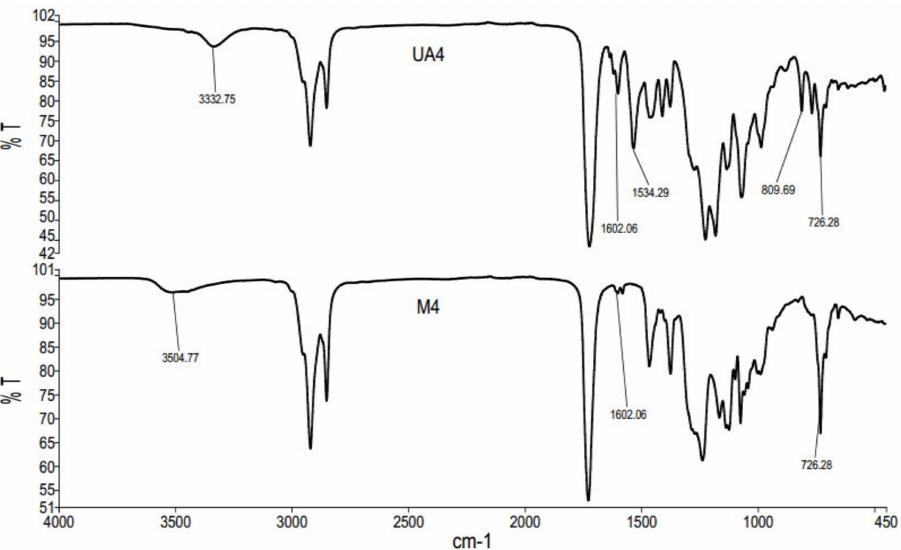
Figure 5. Comparison of the FTIR spectra between the M4 and the urethane acrylic